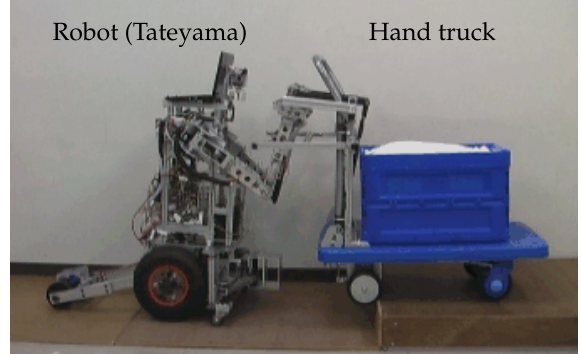
Figure 1. Photograph of the robot and the hand cart